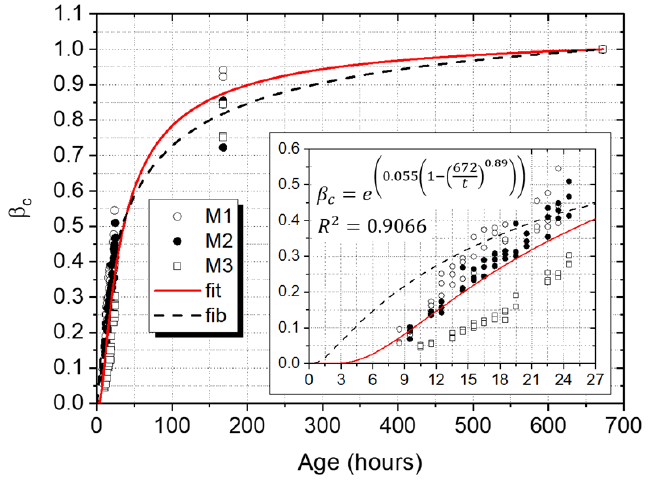
Figure 4 – Variation in the normalized compressive strength over age.